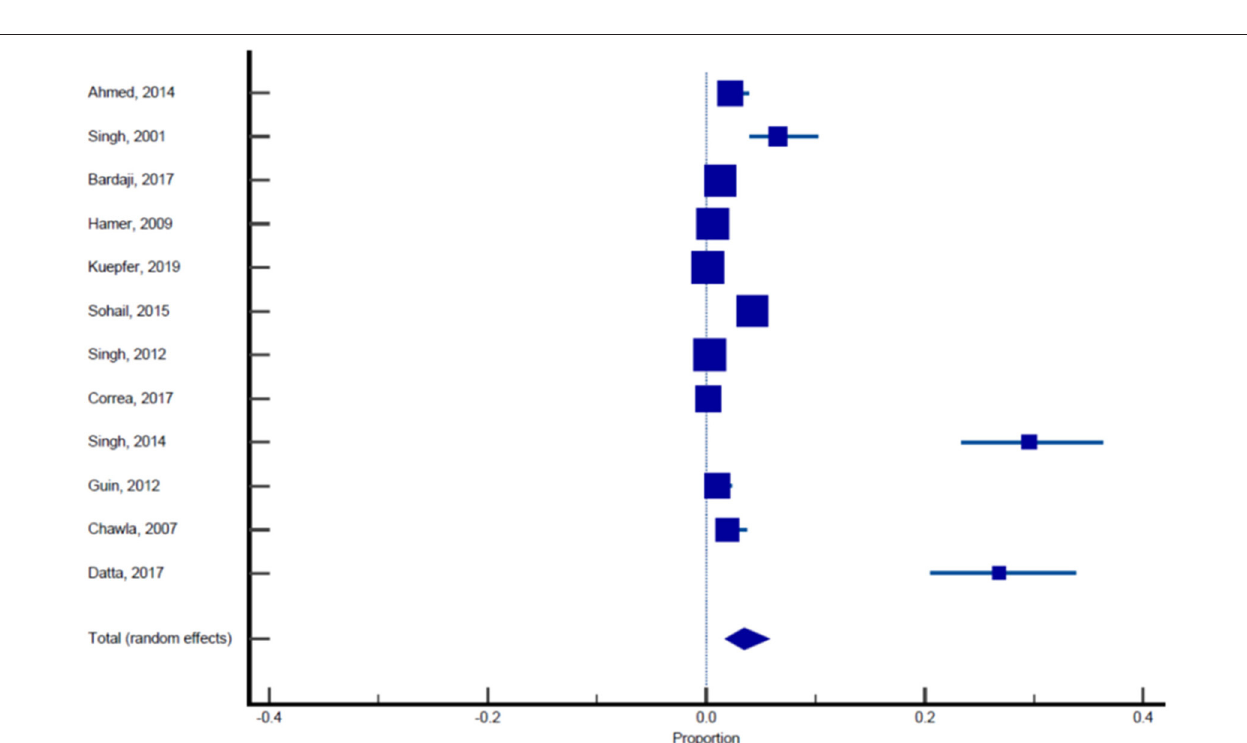
FIGURE 8 | Pooled estimates of the prevalence of Plasmodium vivax infection among pregnant women.